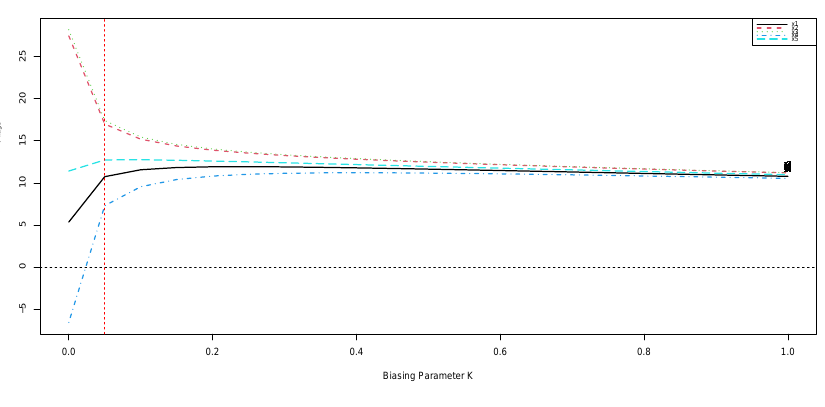
Figure 1. The ridge trace plot, for the first simulated data. Table 1. Estimated regression coefficients for the important variables; bias (SD) based on 200 replications.